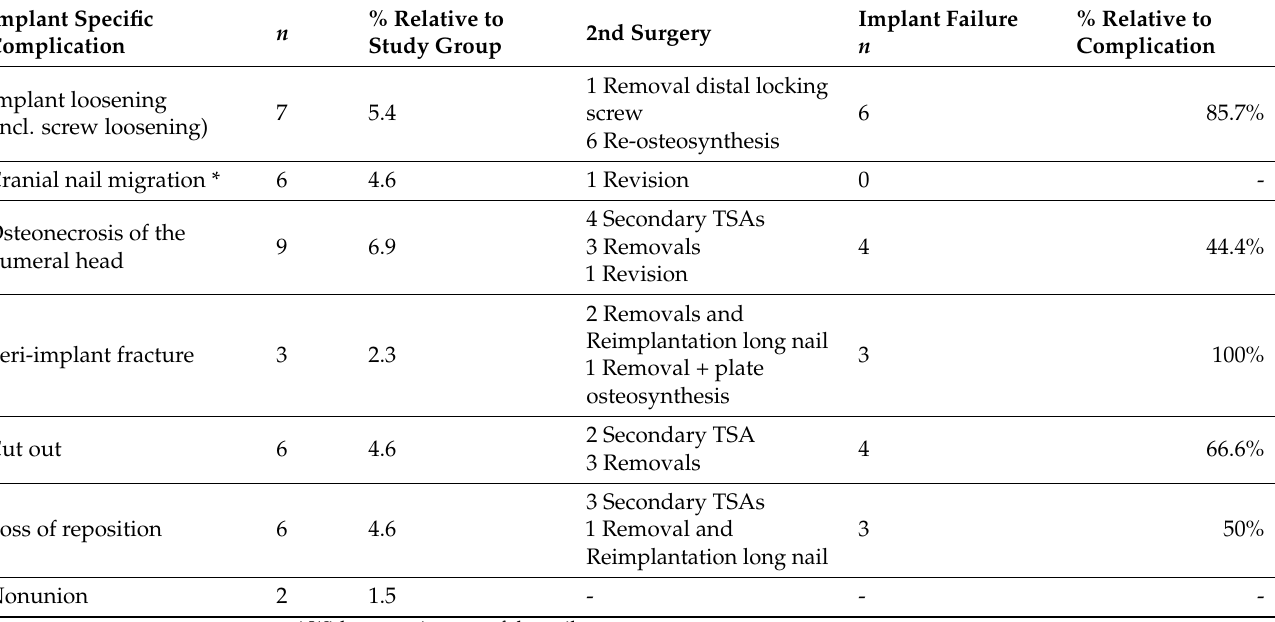
Table 2. Implant-specific complication, revision surgery, and implant failures in the entire study population; TSA = total shoulder arthroplasty.